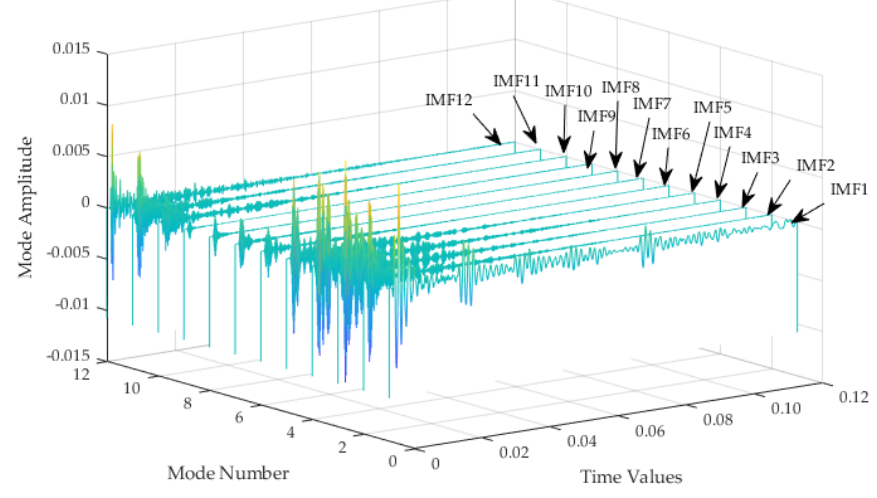
Figure 5. VMD component decomposition diagram.